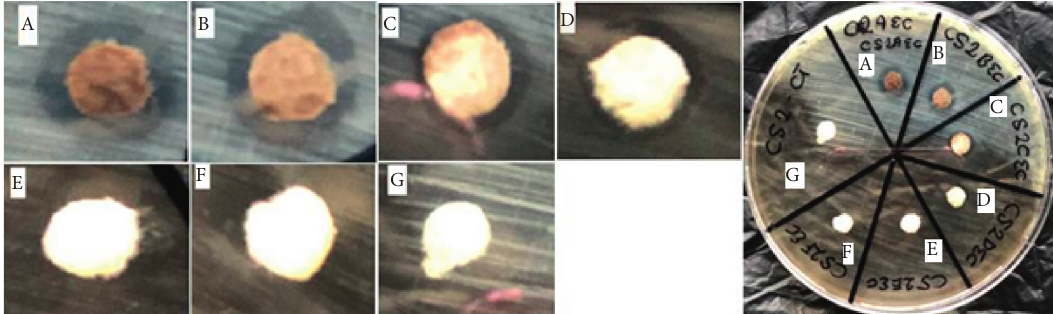
Figure 11: Antibacterial activity of CuO/Ag nanocomposite against E . coli . The paper disks were impregnated with the following suspension of copper oxide nanoparticles: A � 5mg/ml, B � 2 mg/ml, C � 1mg/ml, D � 0.5mg/ml, E � 0.25mg/ml, F � 0.1mg/ml, and G � 0 mg/ml.